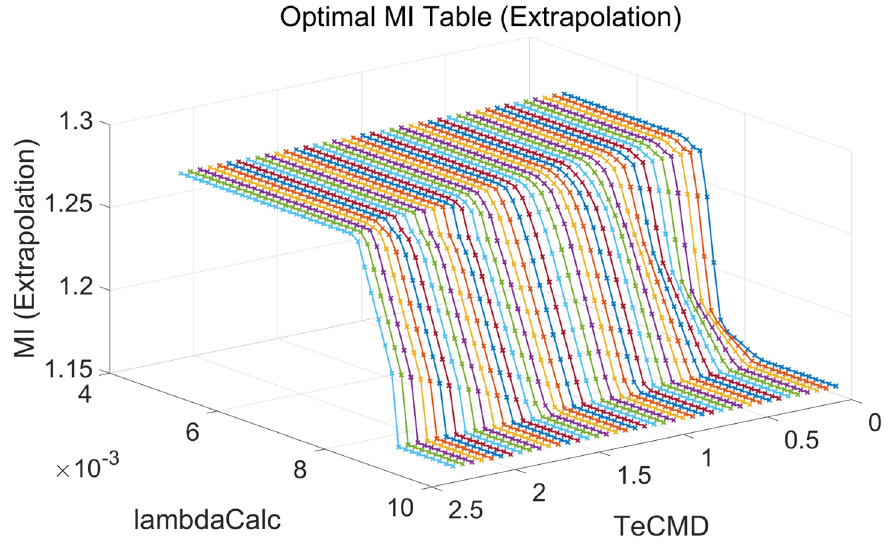
Figure 17. Optimal MI table with increased resolution by interpolation and extrapolation.